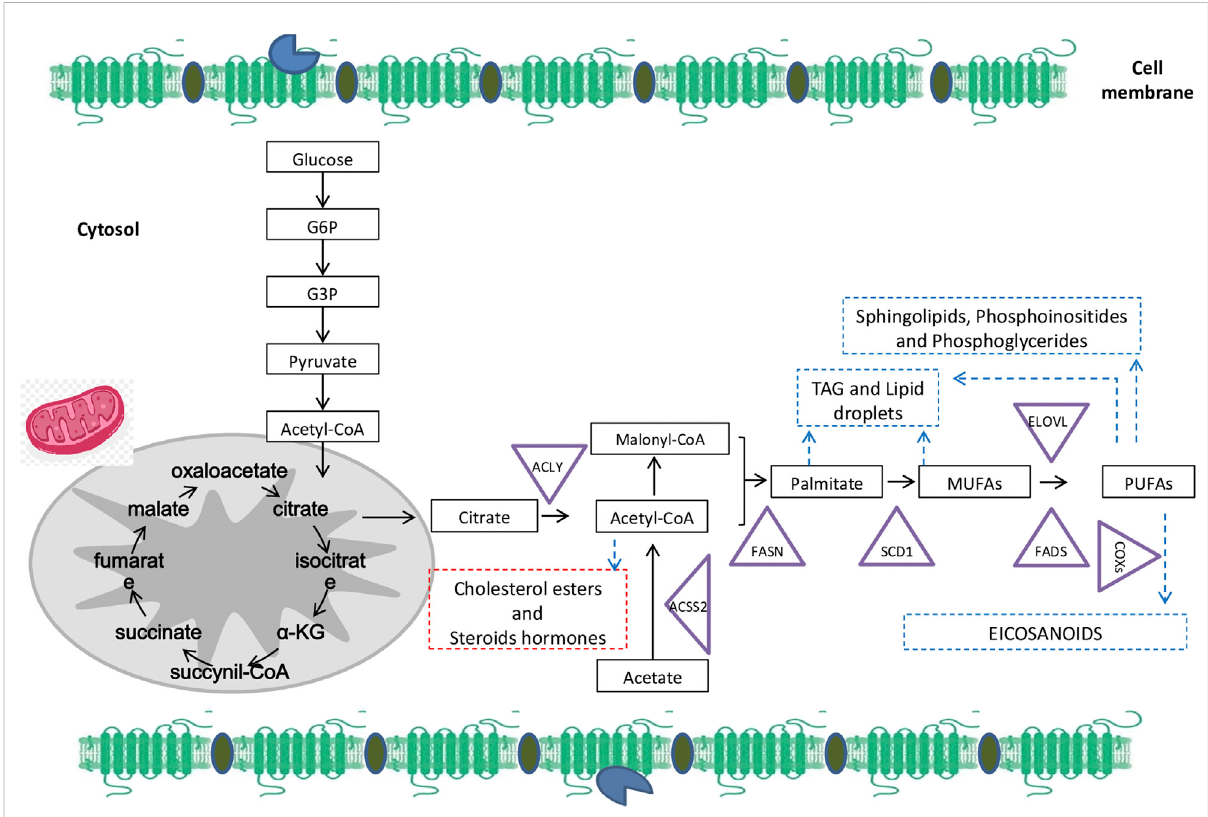
Overallfattyacids(FAs)biosynthesisandmetabolism:The denovo synthesisstartsfromglucosethatgeneratescitrate.Citratecanbecleavedby ATP-citrate lyase (ACLY) to acetyl-CoA that is also metabolized from acetate generated by acetyl-CoA carboxylases (ACSS2). After carboxylation, acetyl-CoA (as well as malonyl-CoA) is condensed by FA synthase (FASN) to give rise to palmitate. Palmitate is catalyzed by the stearoyl-CoA desaturase (SCD1) to synthetize monounsaturated fatty acids (MUFAs) such as oleate and palmitoleate by introducing a double bond between carbons 9 and 10 of the acyl-CoA substrate. MUFAs are desaturated by a desaturase in plants to generate polyunsaturated fatty acids (PUFAs). Moreover, cyclooxygenases (COXs) are able to metabolize PUFAs from 20-carbons to synthetize bioactive lipids with pro or anti-tumor activity (according to the substrate). Whereas, exogenous or endogenous PUFAs are elongated and desaturated by FA elongases (ELOVLs) that add two carbons and desaturases (FADSs) -that add a double-bound between carbon. Abbreviations: α -KG, α -ketoglutarate; G3P, glyceraldehyde-3- phosphate; G6P,